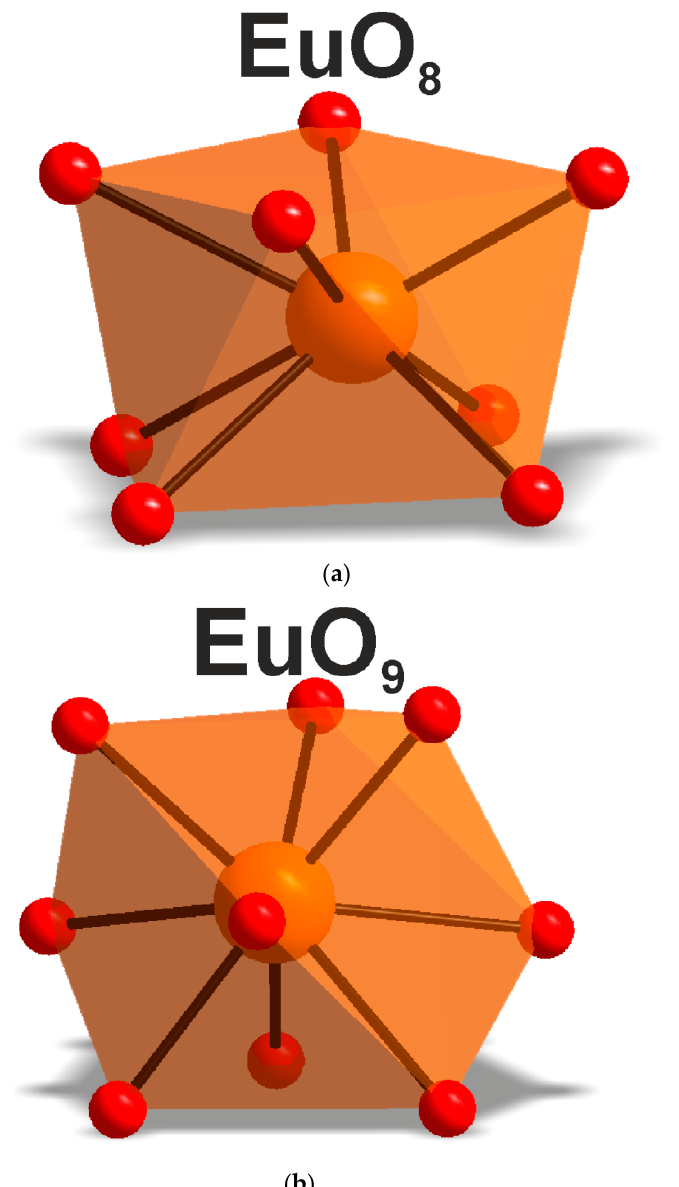
Figure 14. Local environment of the Eu 3+ ion in ( a ) CsEu(SO 4 ) 2 and ( b ) [CsEu(H 2 O) 3 (SO 4 ) 2 ]·H 2 O. The extent of the chemical shift of the ultranarrow Eu line induced by the presence of H 2 O molecules in the vicinity of the Eu site in cesium europium sulfate hydrate, with respect to cesium europium sulfate, is illustrated in more detail in Figure 15. The ultranarrow line position in cesium europium sulfate was at 578.8 nm, while in cesium europium sulfate hydrate it shifted to 579.3 nm.